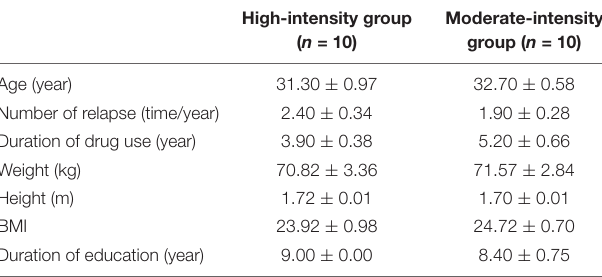
TABLE 1 | Subjects’ demographic characteristics (M ± SE).